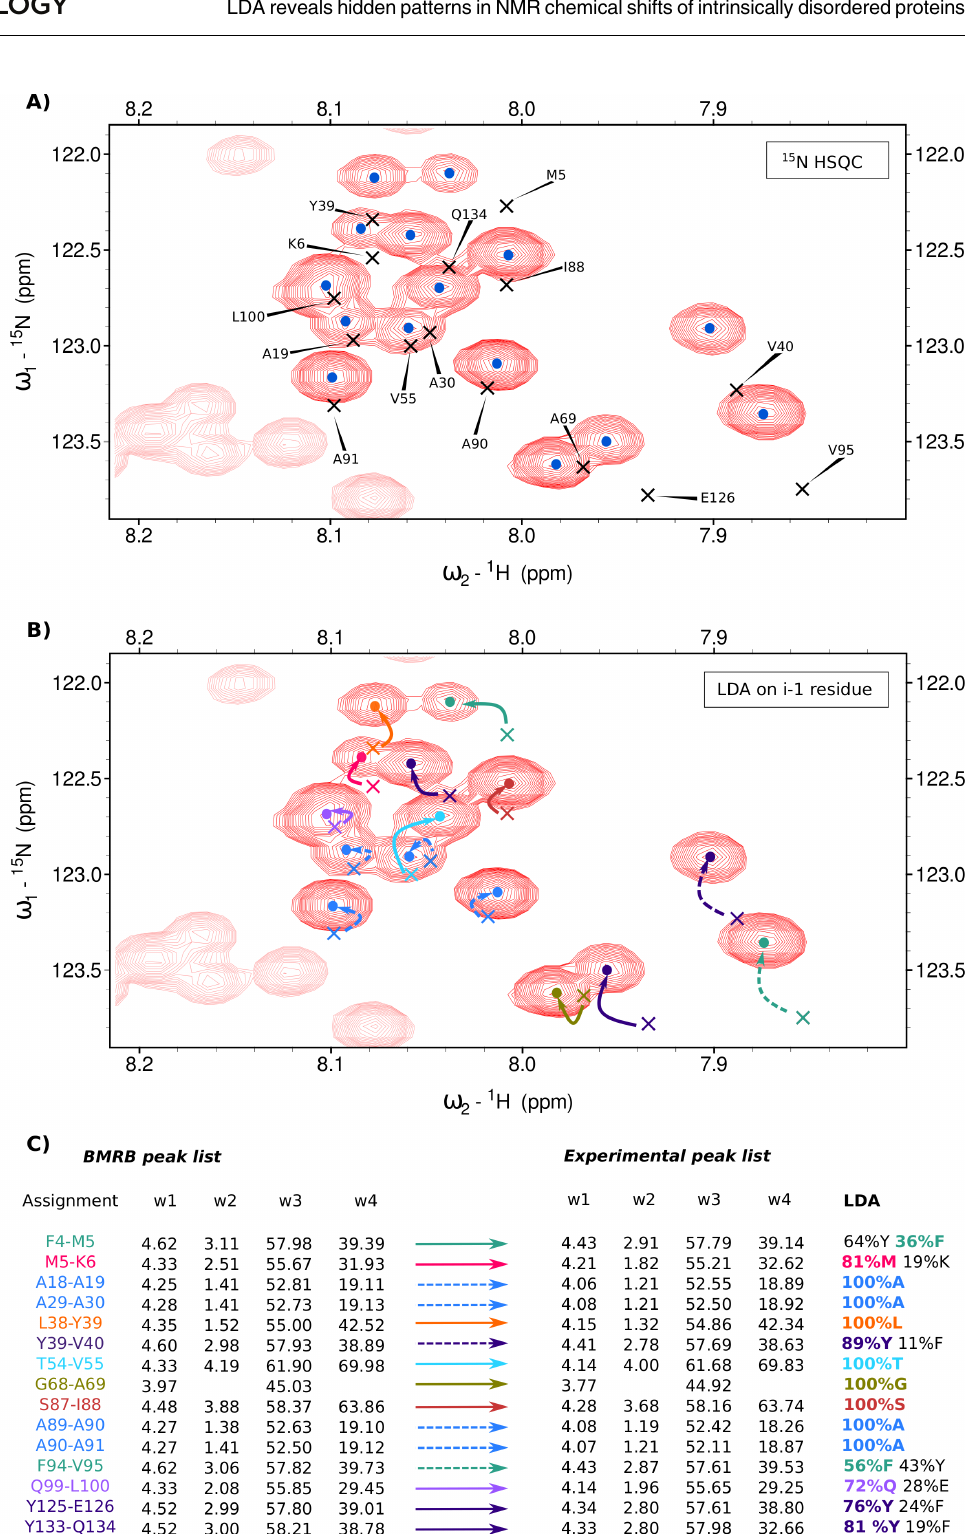
Fig 9. Application of LDA to the resonance list transfer from BMRB Entry 6968 to the experimental spectrum of α - synuclein. A) A fragment of the 15 N-HSQC spectrum with peaks marked with dots. Peaks from the BMRB list are marked with crosses. Labels indicate the corresponding residue name. B) Correct transfer of assignment from BMRB to the experimental peak list (unambiguous assignments shown with solid arrows, more ambiguous ones—with dashed arrows). The experimental and BMRB peaks corresponding to the successors of the residues of the same amino acid type